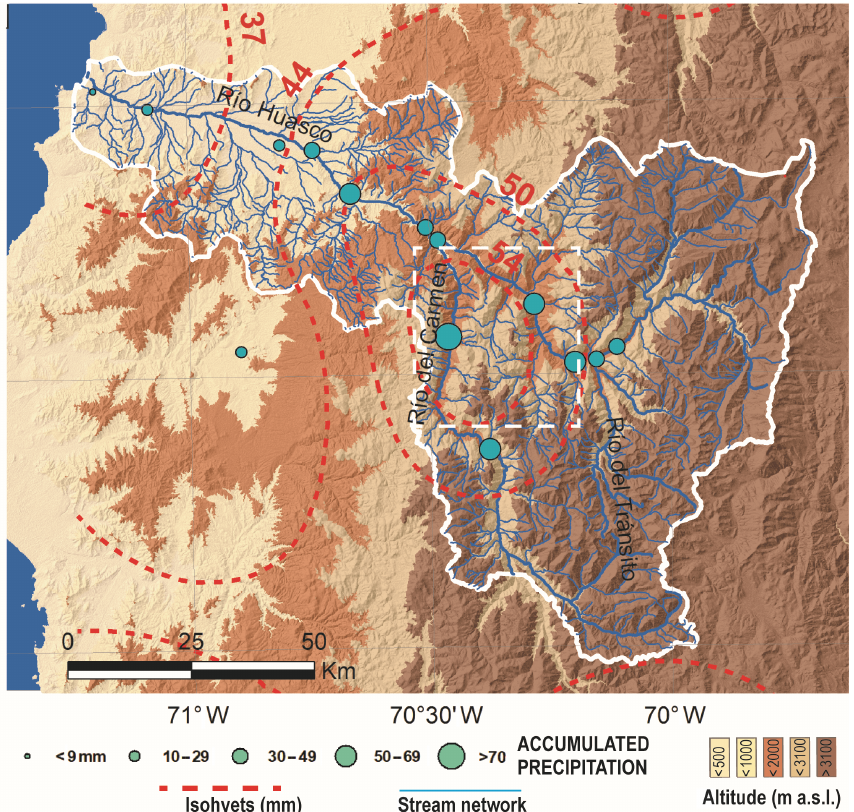
Figure 1. Topography extracted from a digital elevation model courtesy of the NASA JPL Caltech with a nominal spatial pixel resolution of 30m × 30m (https://asterweb.jpl.nasa.gov/gdem.asp, last access: 6 May 2020) and modeled hydrology of the Huasco River valley. Dotted red lines show the isohyets of daily accumulated rains during the 23–26 March storm by kriging interpolation of meteorological data from the Dirección General de Aguas, Chile. Cyan points show the accumulated rainfall in each meteorological station during the March 2015 storm. The box outlined with a dashed white line shows the studied